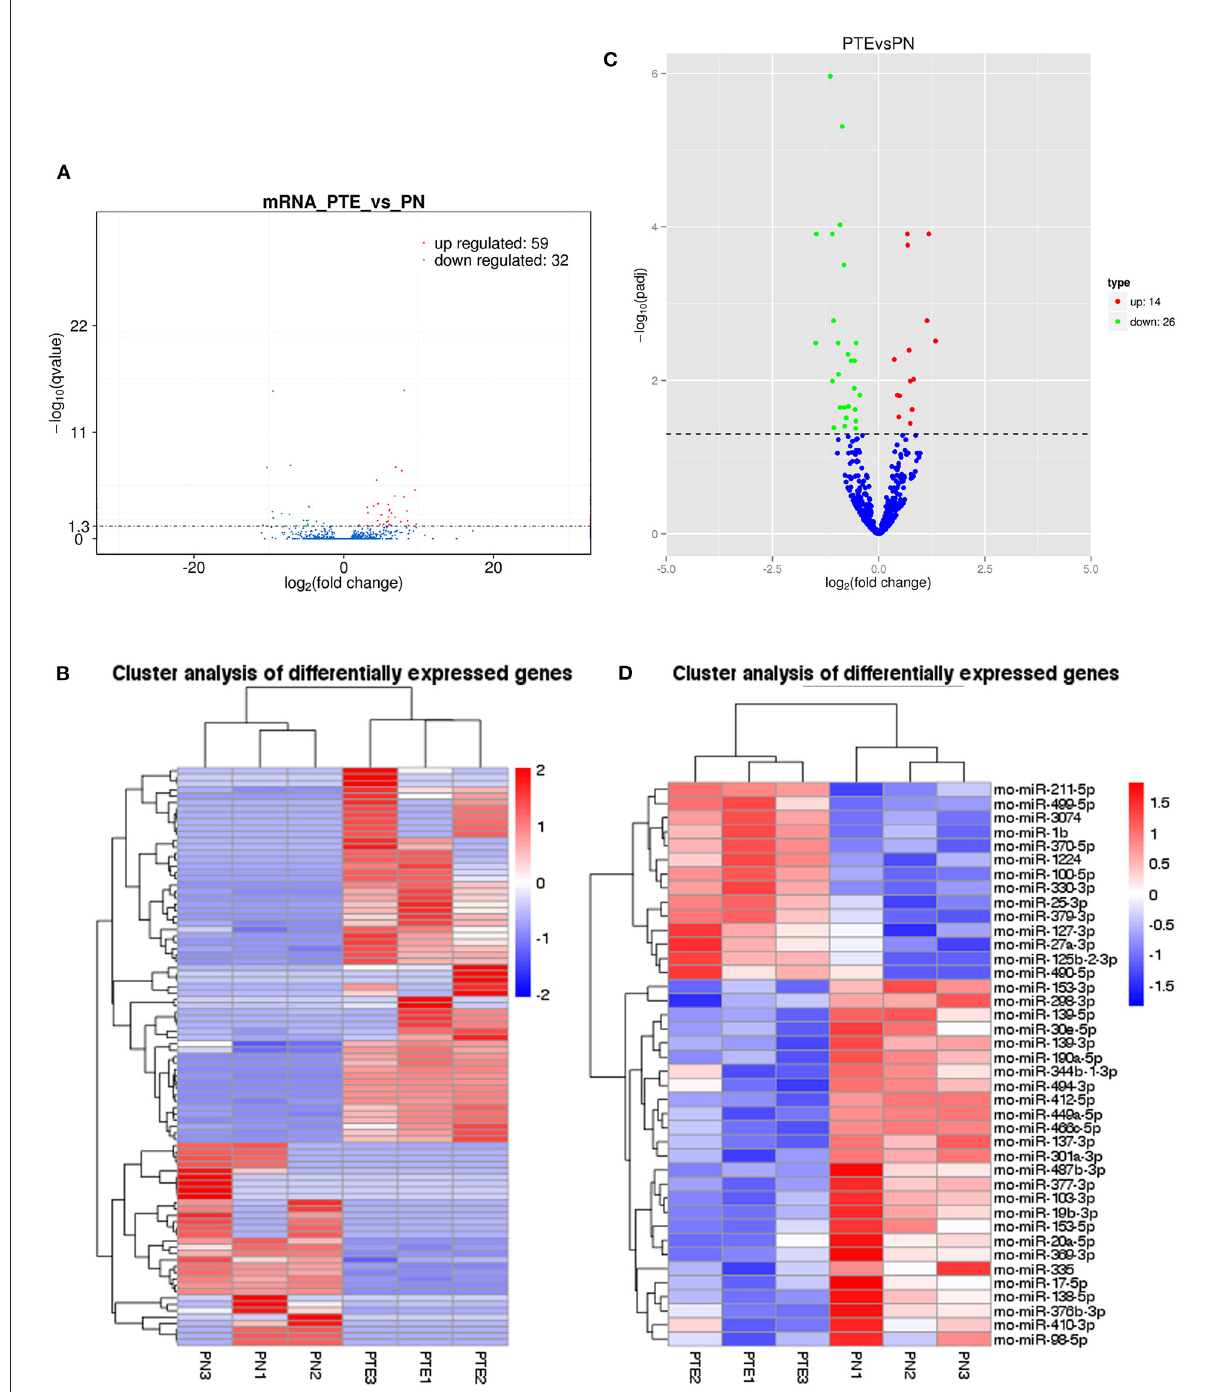
FIGURE2 mRNA and miRNA transcriptome analysis in rat frontal lobe by RNA sequencing (RNA-Seq). (A) A volcano plot of mRNA sequence transcriptome data displays gene expression values of PTE rats compared with those of sham rats. Significantly differentially expressed genes (adjusted P -value < 0.05) are highlighted in red (upregulated) or blue (downregulated). Non-differentially expressed genes are highlighted in green. n = 6. (B) Heat map of 59 significantly upregulated and 32 significantly downregulated mRNAs in PTE rats compared with sham rats. (C) A volcano plot of miRNA sequence transcriptome data displays gene expression values of PTE rats compared with those of sham rats. Significantly differentially expressed genes (adjusted P -value < 0.05) are highlighted in red (upregulated) or blue (downregulated). Non-differentially expressed genes are highlighted in green. n = 6. (D) Heat map of 14 significantly upregulated and 26 significantly downregulated miRNAs in PTE rats compared with sham